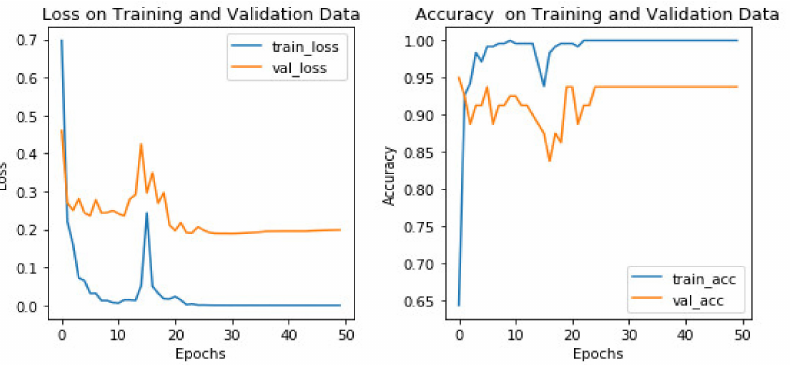
Figure 12. Loss and